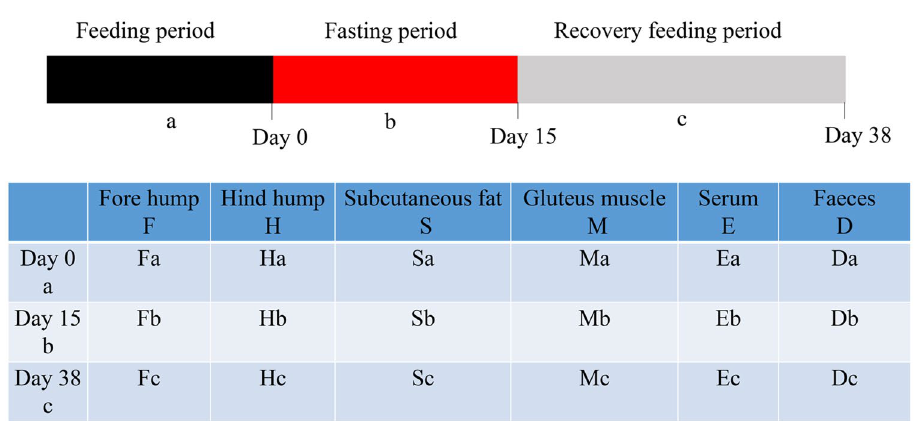
Figure 8. Experimental design and sample collection